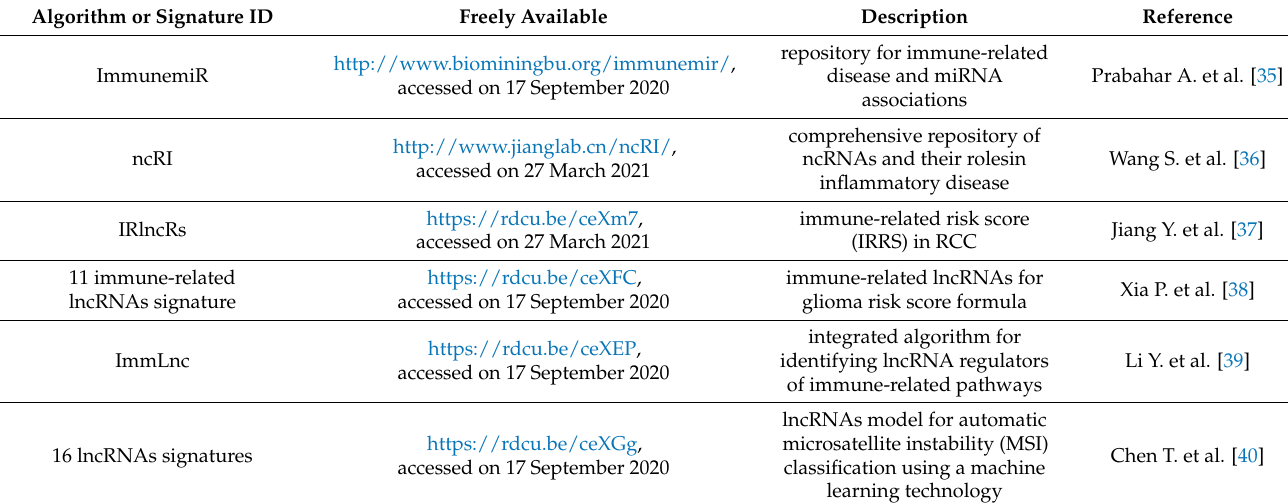
Table 2. Tools supporting an interactive integration of ncRNA players and targeting immune-related